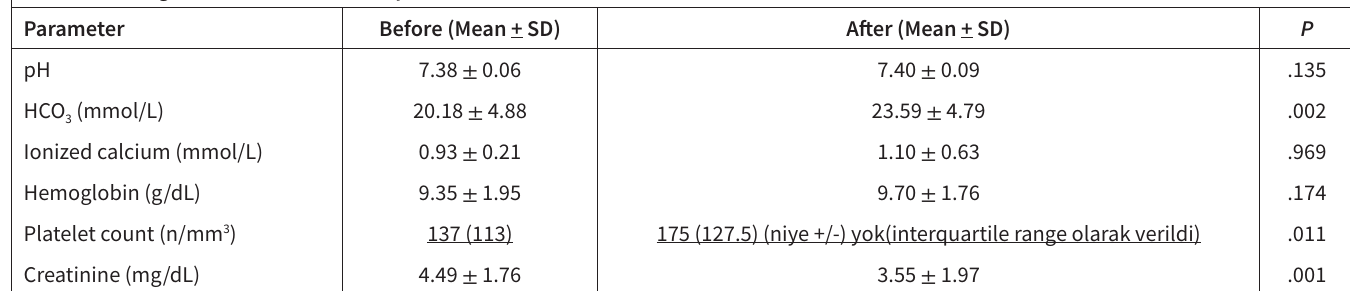
Table 3. Changes in Patients' Laboratory Parameters After the Procedure